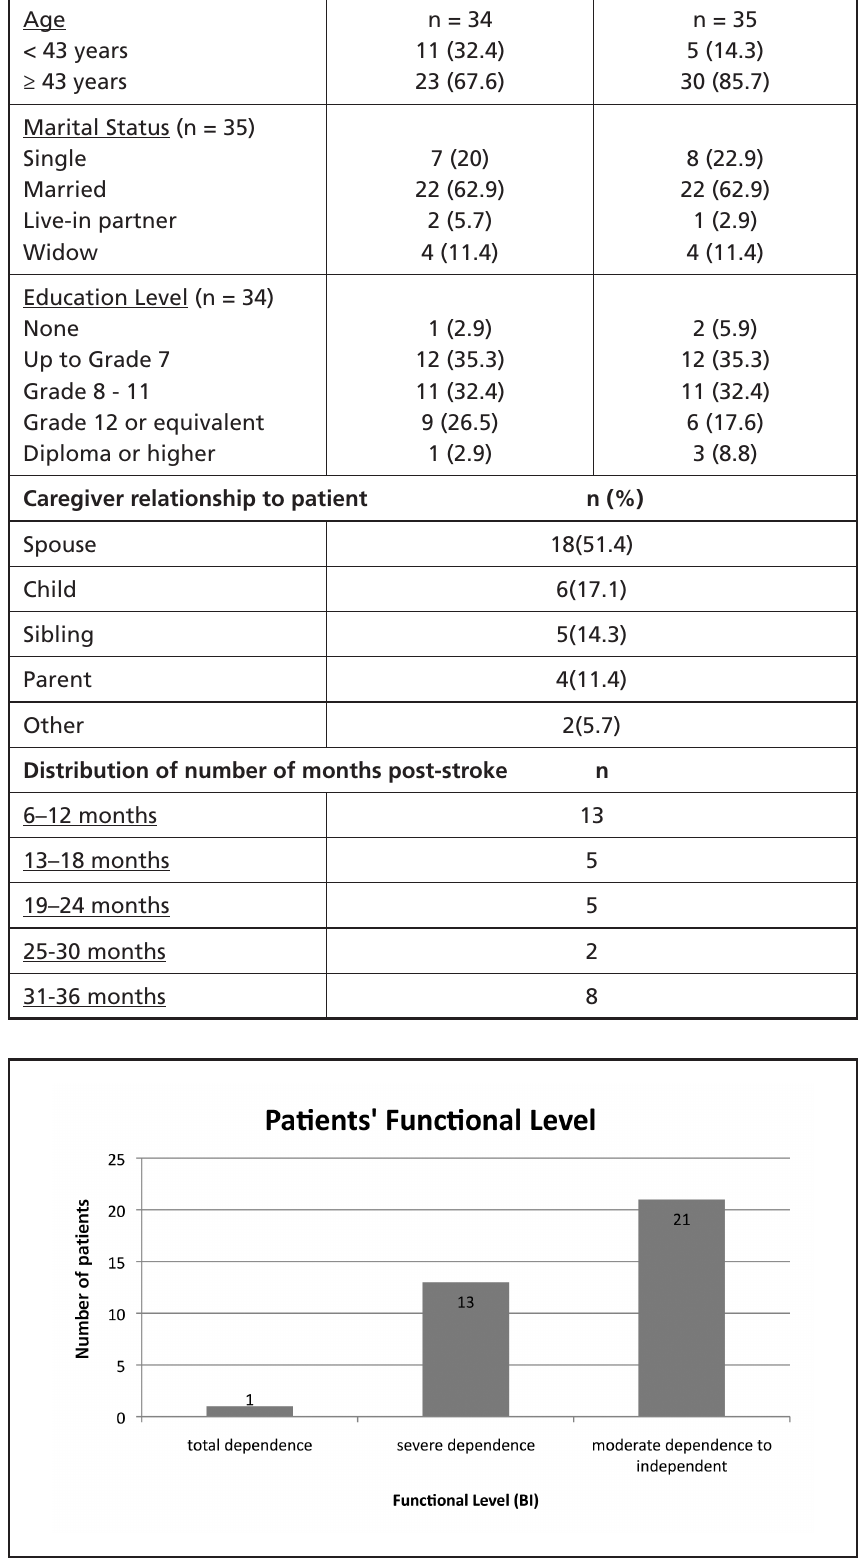
Figure 1: Functional level of the patients with stroke six – 36 months post